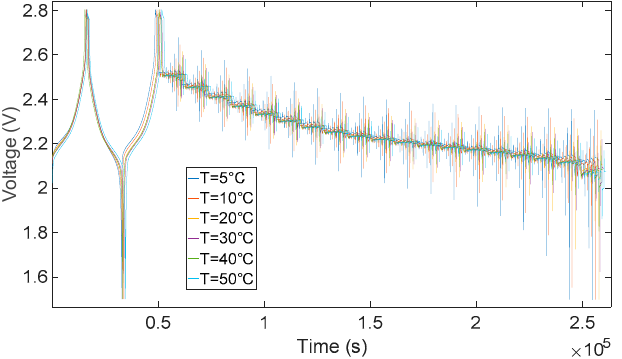
Figure 7. The voltage response of the battery cell to charging and discharging current pulses.